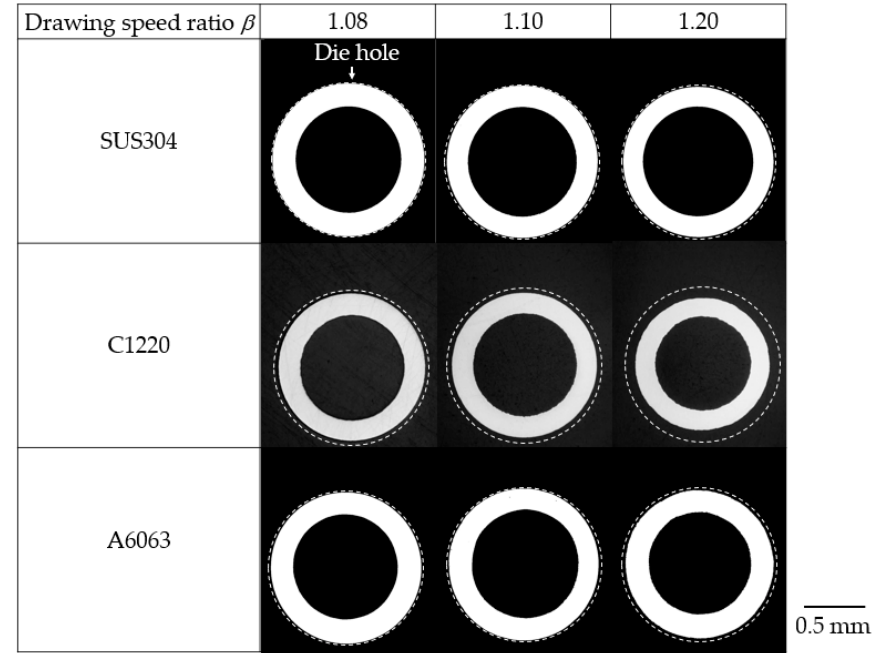
Figure 7. Cross sections of the drawn tubes at a die reduction R e of 0.17 for each material. The diameter of the dotted circle was drawn to show the size of the exit hole of the die. The results of the copper tubes were already shown in our previous paper [10].